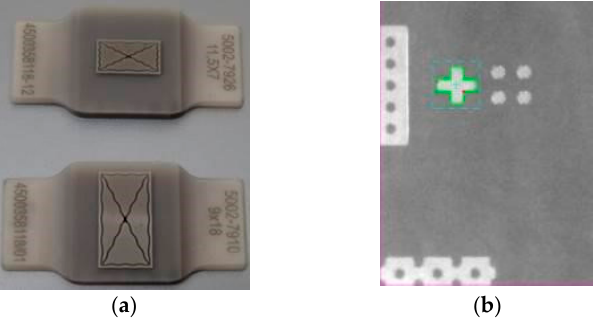
Figure 3. ( a ) Customized thermodes for bonding the quartz cover and silicon die; ( b ) Alignment mark on substrate wafer under optimized light